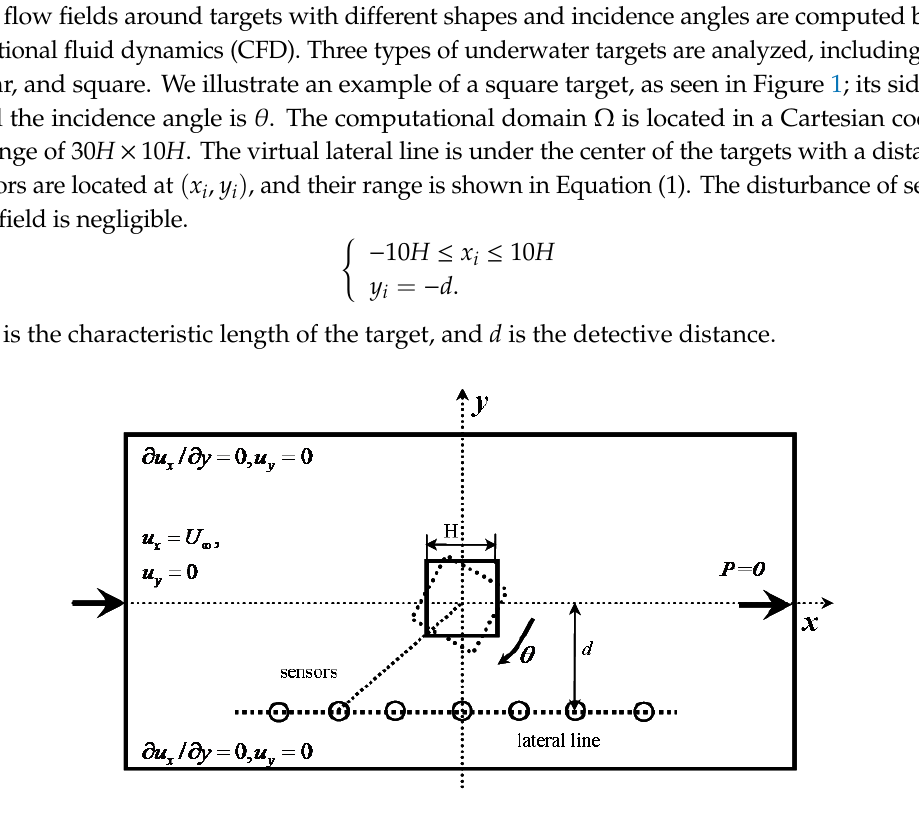
Figure 1. Schematic diagram of the computational domain for a square target .